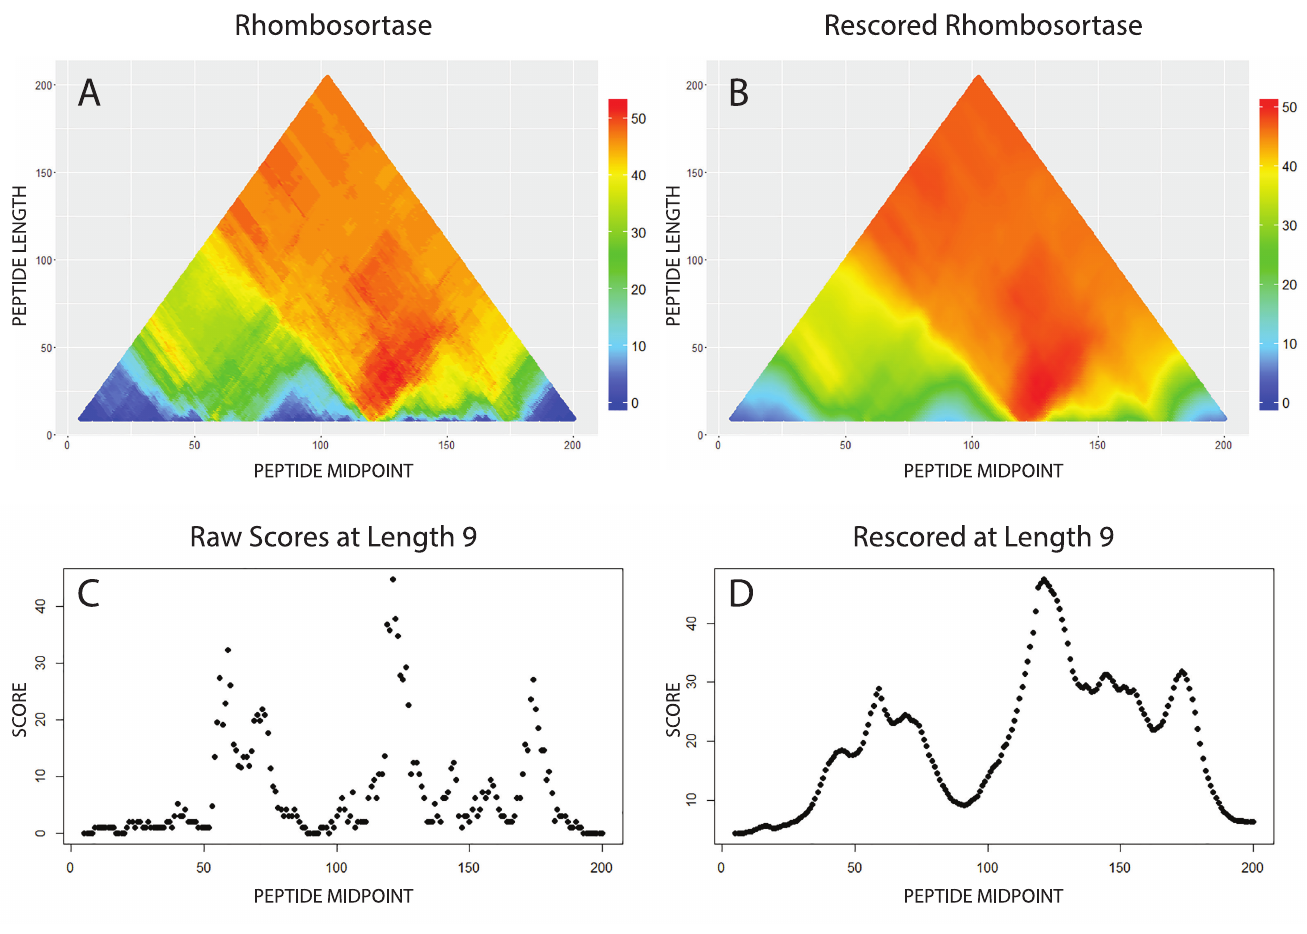
Fig 2. Graphical output from SIMBAL computation and post-processing. Fig 2A shows the triangleheat map obtainedfor query sequence NP_718091.1, a rhombosortase from Shewanella oneidensis MR-1, obtained as describedin the text. Each colored pixel in the heat map conveys three pieces of information: a SIMBAL score (color, where red indicatesgreater statistical significance), the length of the subsequence being scores (height on the Y-axis), and the location of the middle of the subsequence along the length of the completeprotein (positionon the X-axis). Subsequences are evaluatedfrom a minimum lengthof 9 (bottom of the heat map) to a maximum of 204, the full length of the protein, at the top of the heatmap. Scores are computedas the negativelog 10 of the odds againstencountering,purelyby chance, at least as great a preponderance of YES set-derived sequencesamongthe top BLAST hits. Note that nearby pixels may differ sharply in score, and that the deepest red colors appearin a “plume” of pixels whose correspondingsubsequences all containthe same key small region. Fig 2 B shows a smoothed heatmap that results from re-processing SIMBAL scores so that each pixel represents a blend of its own score and those of longersequencesthat containit, performed iteratively starting with the longest sequences. The heritabilityparameter used was 0.93. Fig 2 C shows data in numerical form corresponding to a line passing through the heatmapof Fig 2 A very near its base, at a subsequence length of 9, with height rather than color showingthe score. Fig 2 D shows the correspondingslice through the rescoredheatmap of Fig 2B, with a greatly reducedjitter in scores from one pixel to the next, and a clear indication of which short subsequences most likely containkey sites that discriminate rhombosortases from other rhomboid family